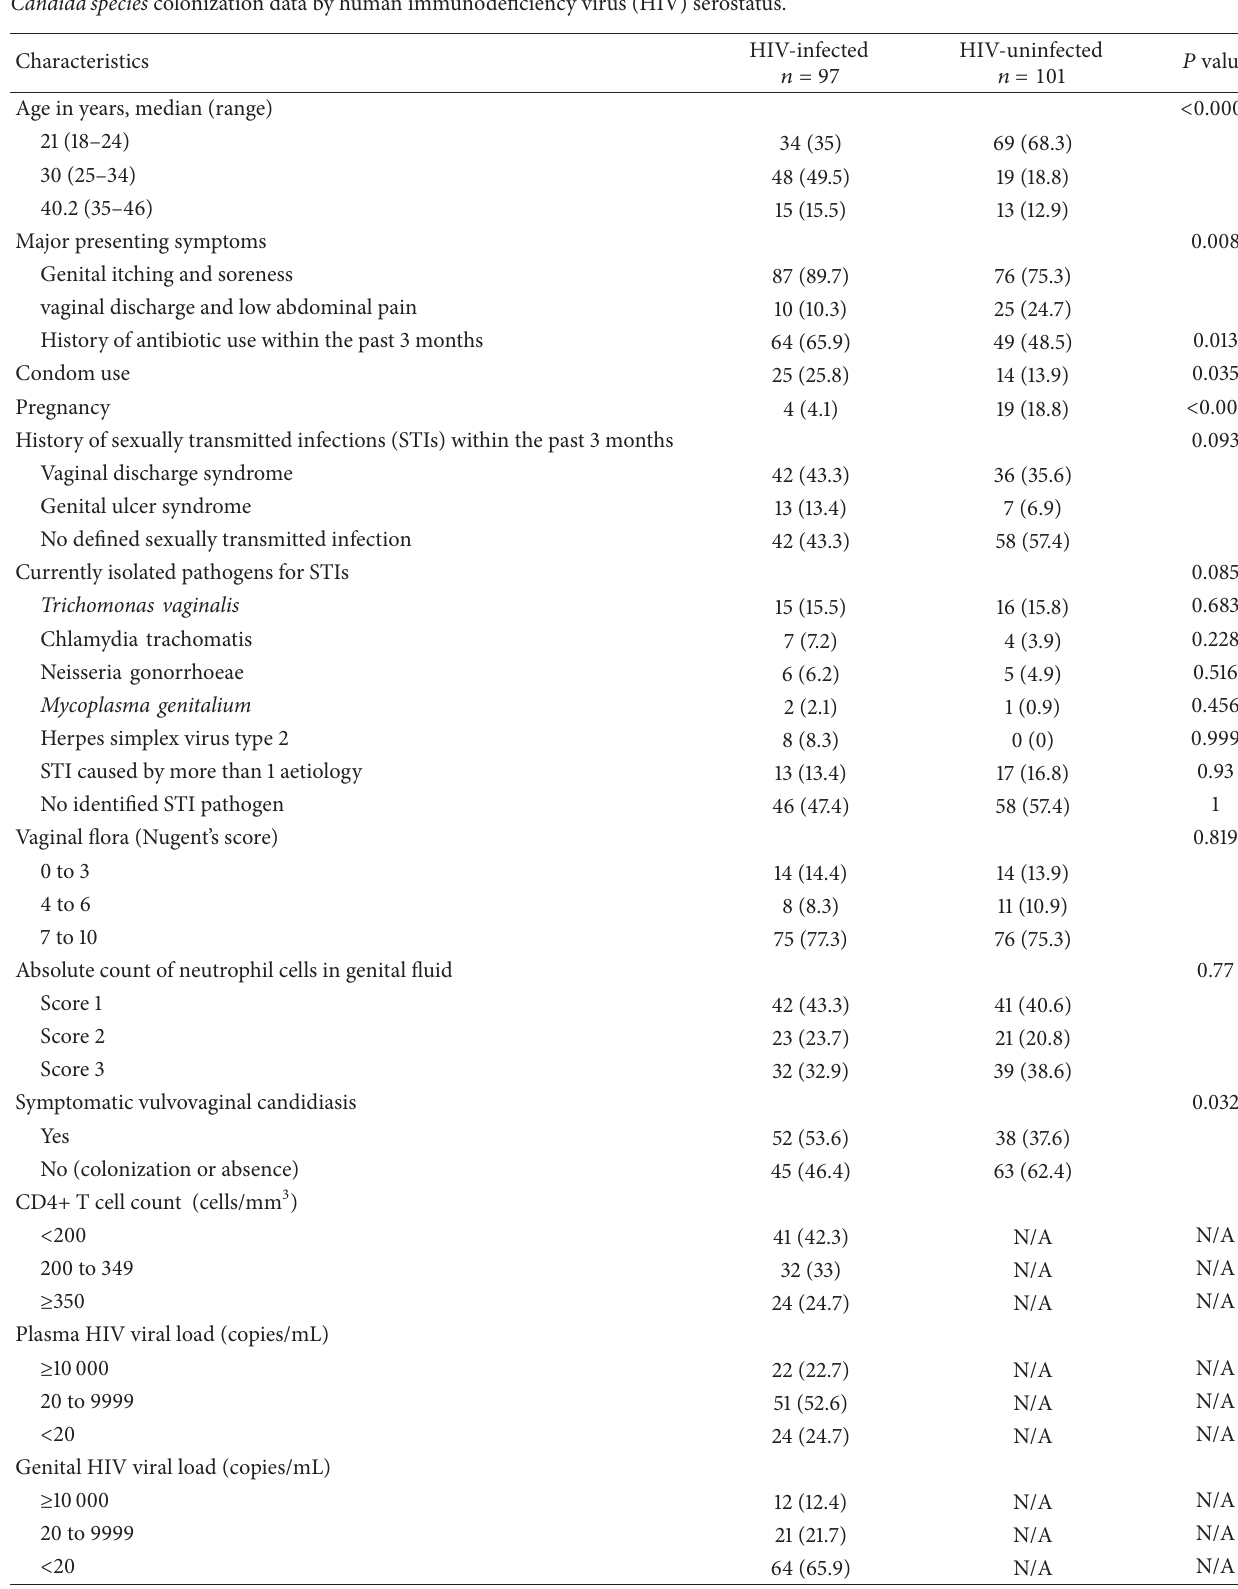
Table 1: Baseline characteristics of the study population ( 𝑛 = 198 ) who contributed symptomatic vulvovaginal candidiasis (VVC) and vaginal Candida species colonization data by human immunodeficiency virus (HIV)